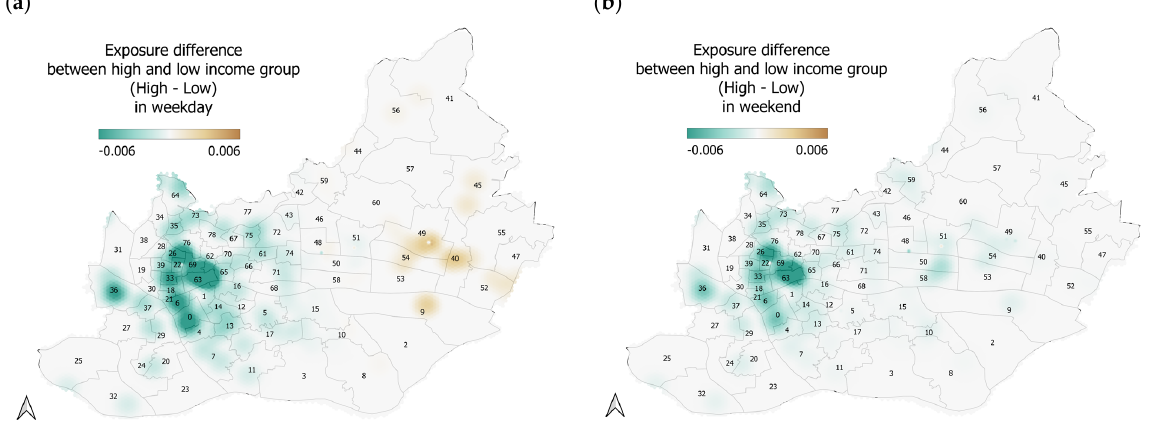
Figure 14. Exposure comparison between high- and low-income groups: ( a ) Weekday; ( b ) Weekend.